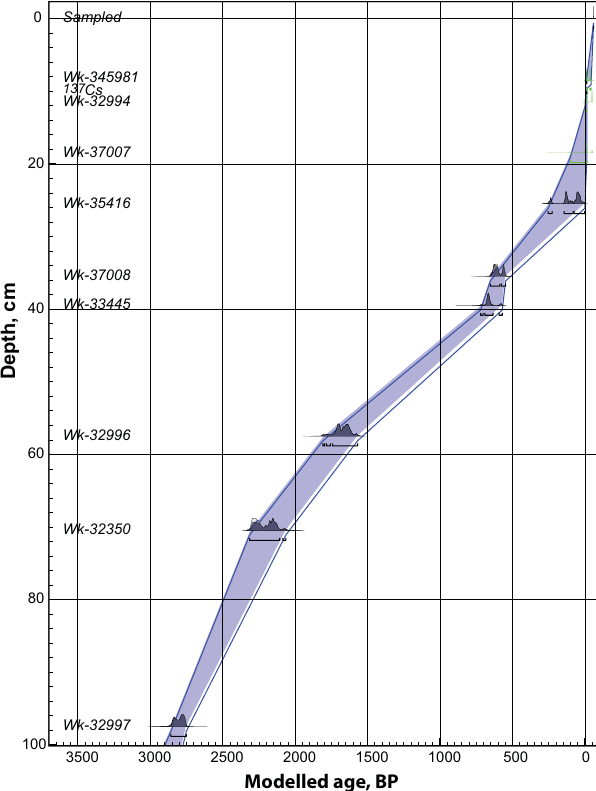
Figure 3. Age–depth plot for Canopus Hill, Port Stanley Airport, with 1 σ age range (blue envelope) and probability